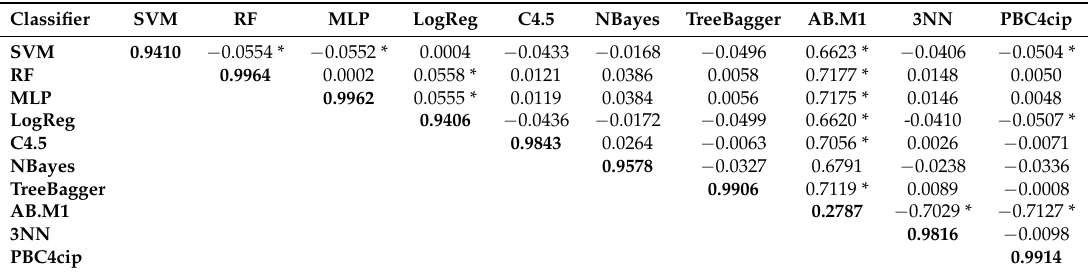
Table 4. Average AUC results obtained by the tested classifiers in our proposed